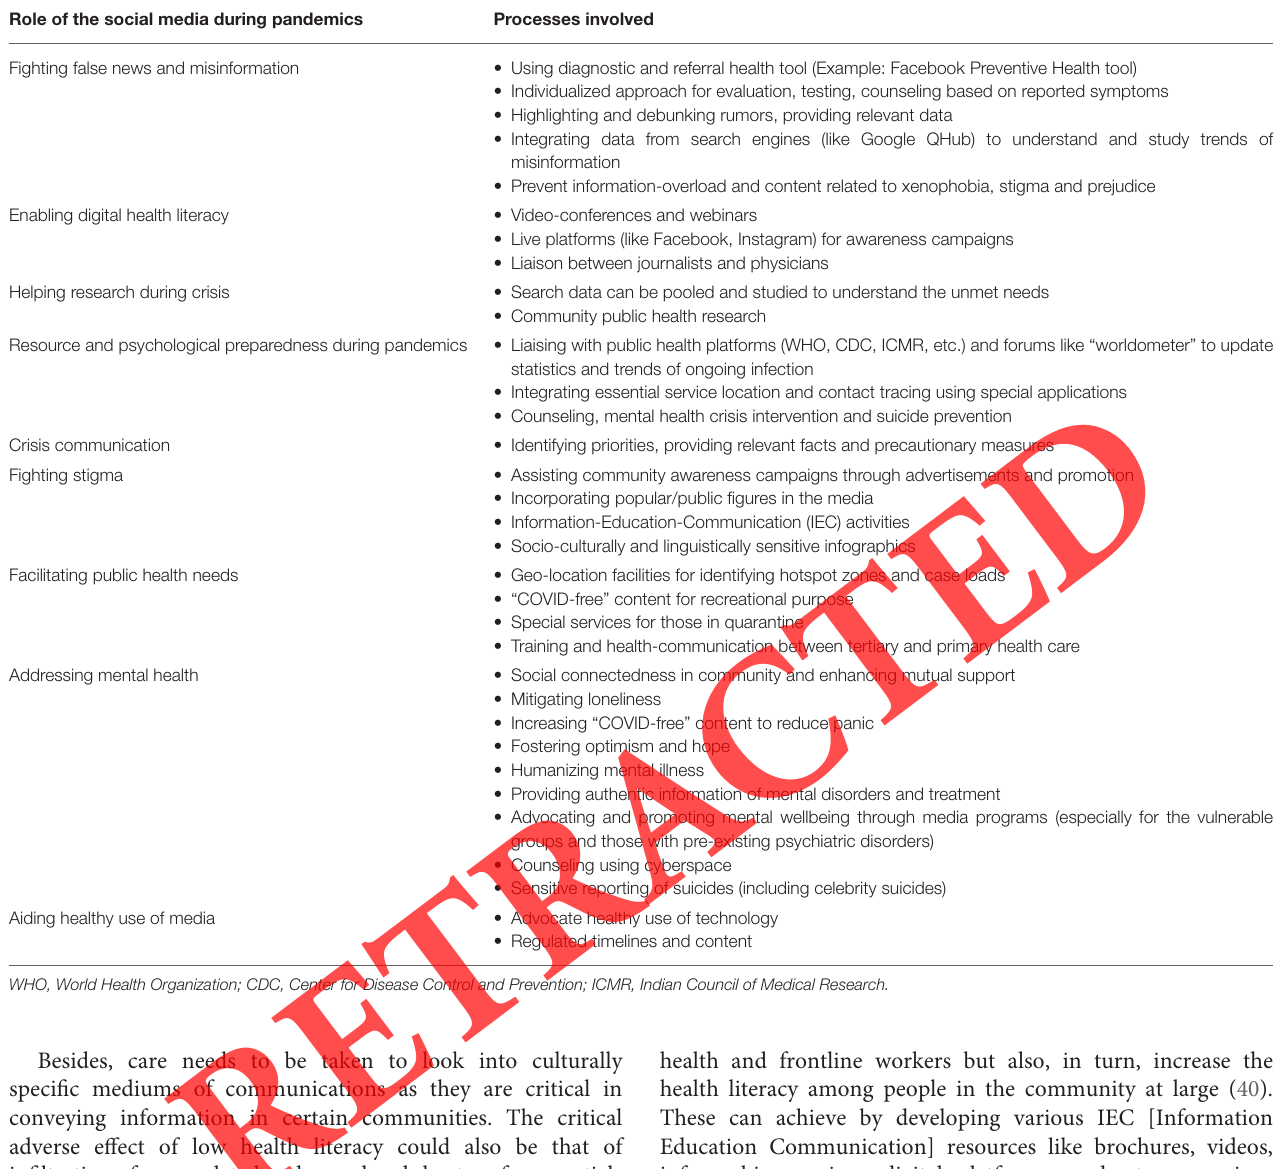
TABLE 1 | Possible roles of social media during